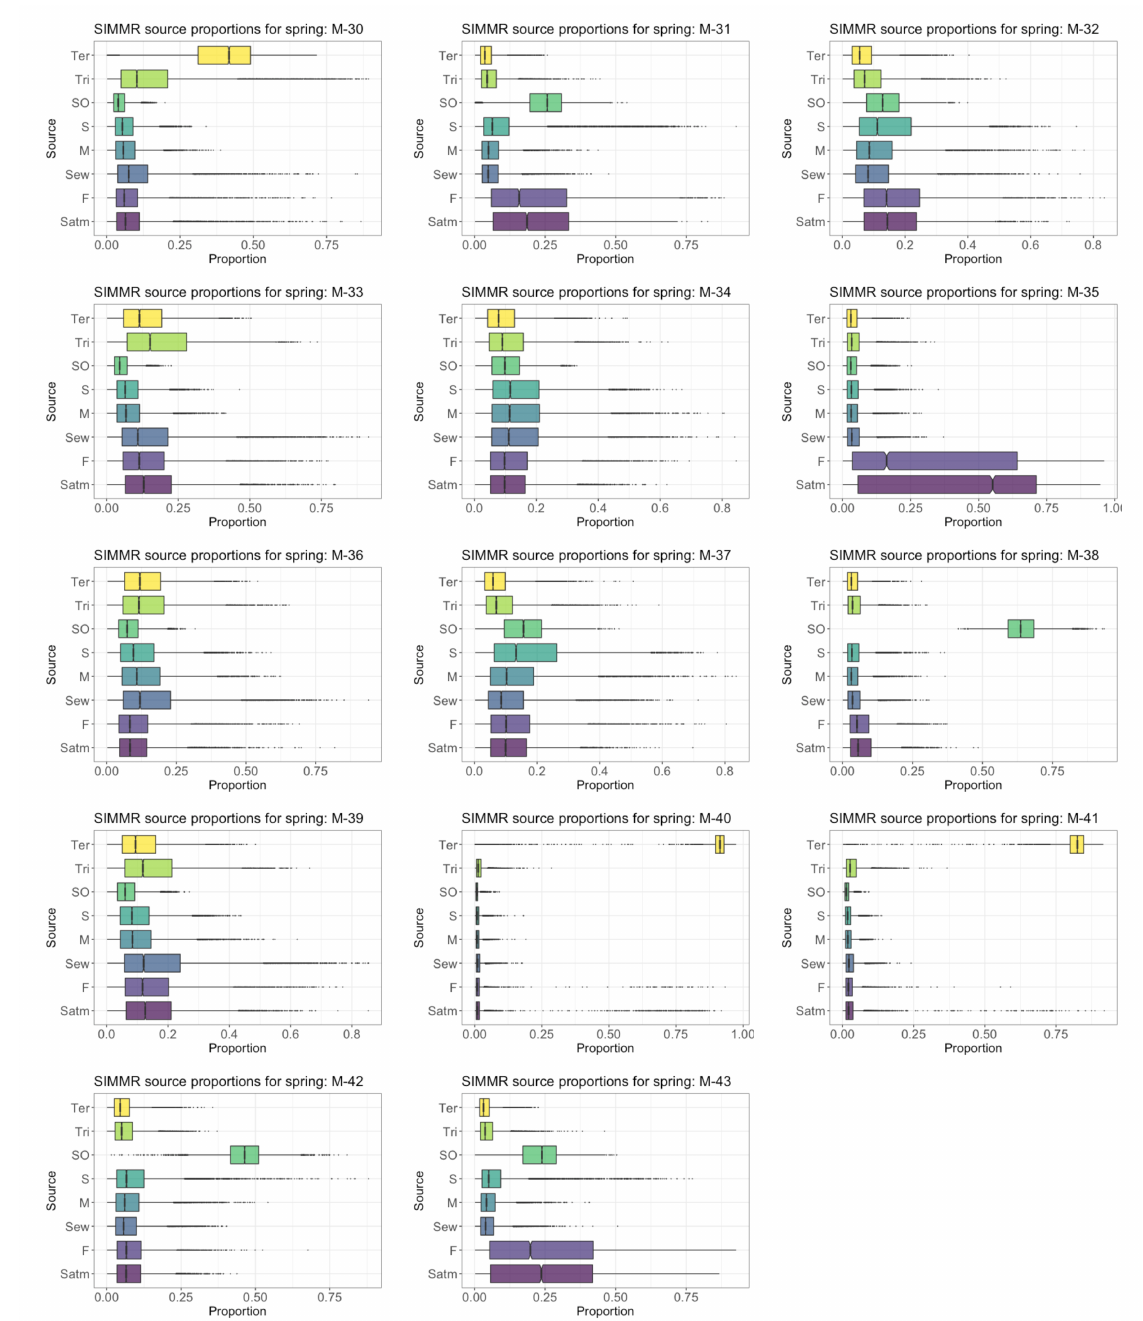
Figure A5. Bayesian isotope mixing model outputs for S and O from SO 4 for all 38 springs. The considered sources are the same of the biplots (Figure 9): (SO) sulfide oxidation; (M) manure; (S) soil; (Satm) atmosphere deposition (F) fertilizers; (S) sewage; (Tri) Triassic evaporites and (Ter) Tertiary evaporites. In total 209 samples that were averaged from 38 springs were available of the 43 springs in total. No samples could be prepared for the remaining 5 springs (M-14, M-15, M-16, M-17, and M-18) corresponding to those with lower concentrations of sulfate and situated at the highest part of the massif and associated with cluster